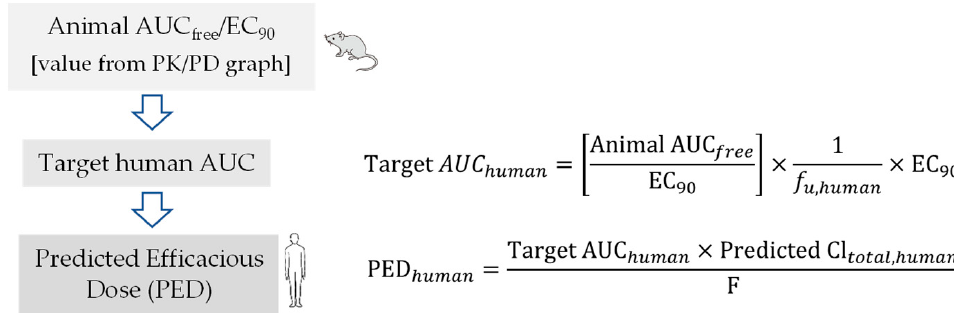
Figure 3. Flow chart for prediction of human efficacious dose using animal AUC free /EC 90. Animal AUC free /EC 90 value is estimated from PK/PD graph. Human PED is estimated using calculated Target human AUC value using above mathematical expression.